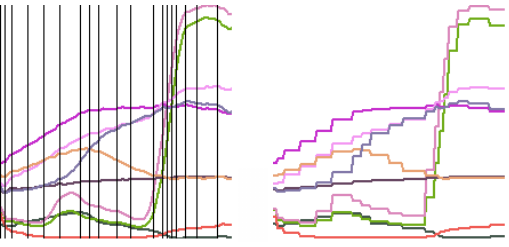
Figure 2: On the left, examples of merged bands superimposed on the original reference spectra. On the right, piece-wise constant reconstructed spectra for these merged bands (Pavia data